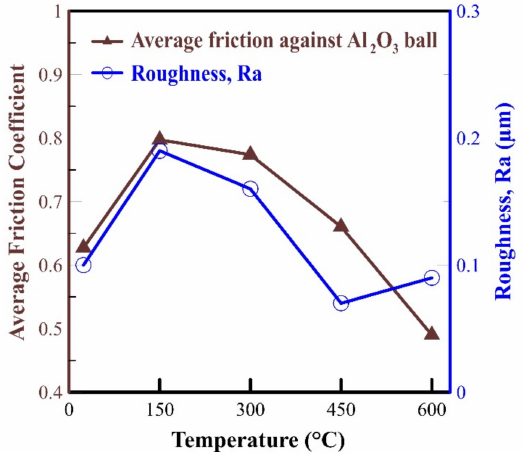
Figure 6. Variations of friction coe ffi cient with sliding distance for HiPIMS-TiN coated HSS tested at di ff erent temperatures: ( a ) linear x-axis, ( b ) logarithmic x -axis. The ball-on-disc abrasive test was conducted at various temperatures with an Al 2 O 3 ball.